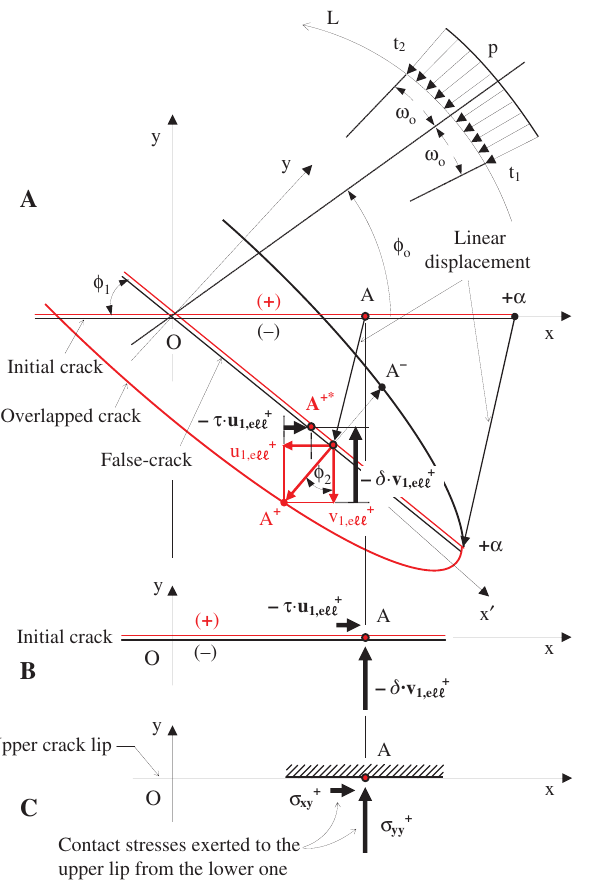
Figure 5 Schematic representation of the generation of contact stresses (out of